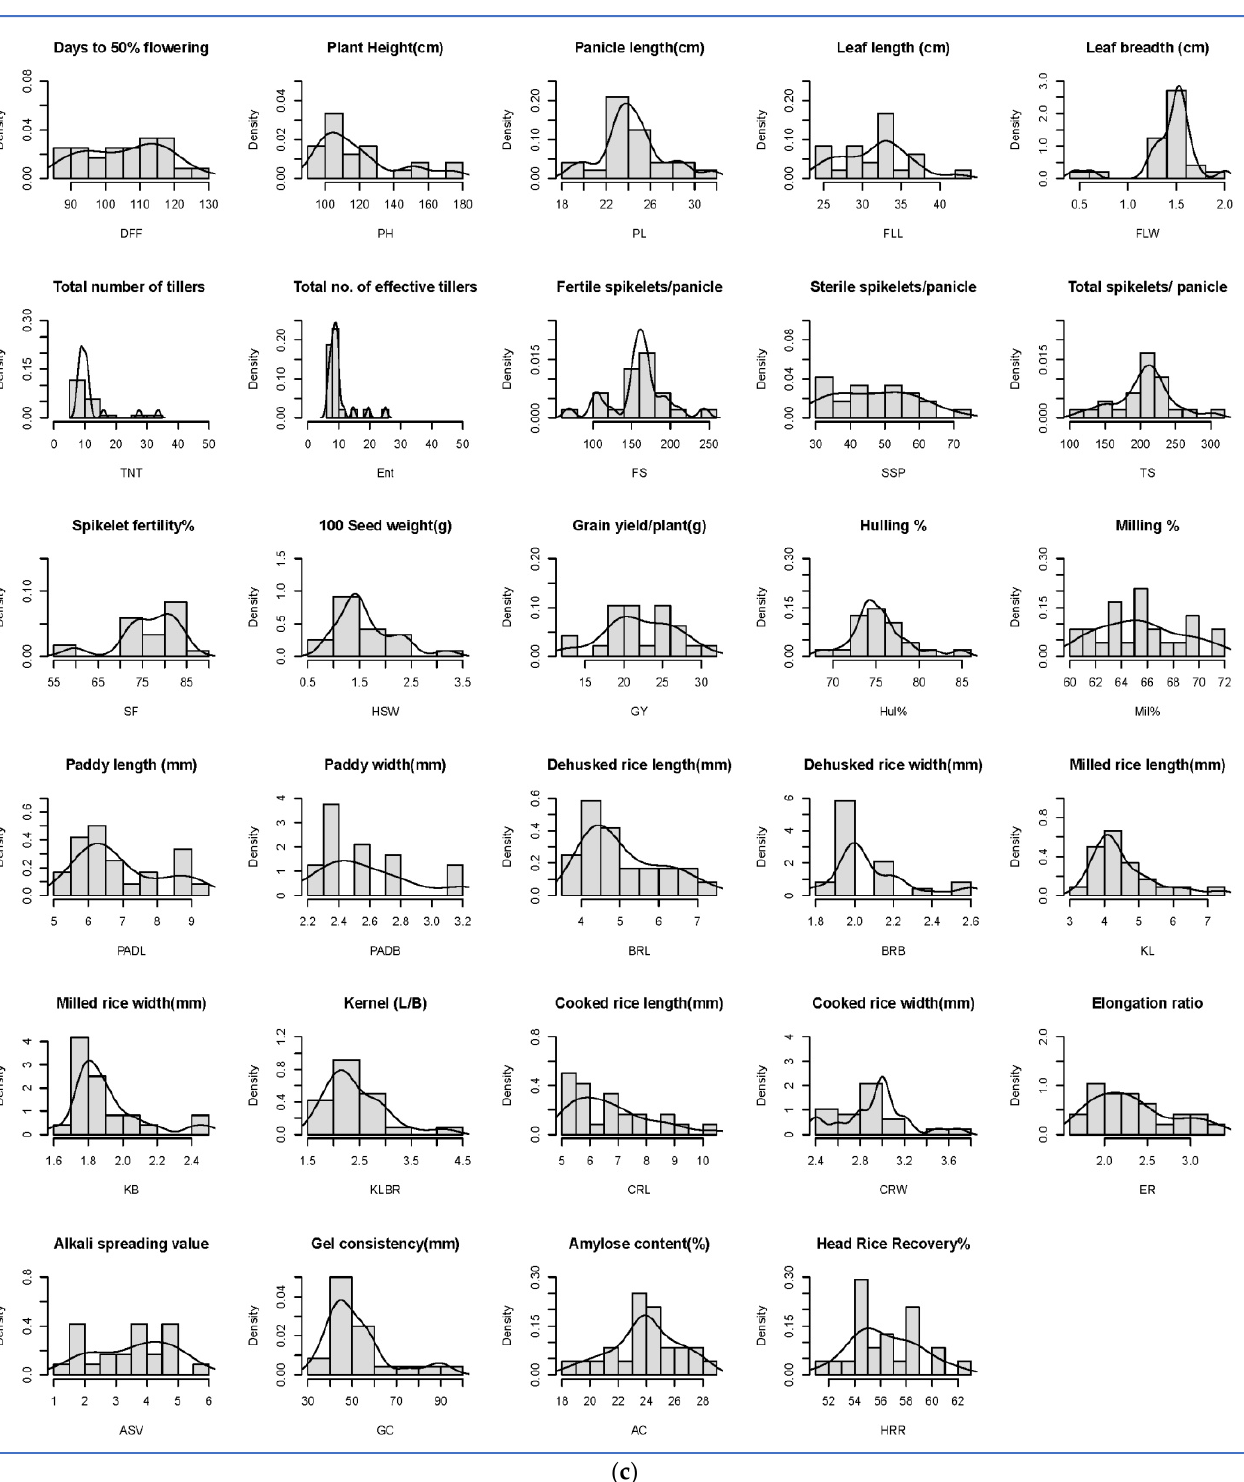
Figure 2. ( a ). Frequency distribution-based histogram for all the traits during the Kharif (wet) season—2019. ( b ). Frequency distribution-based histogram for all the traits during the Rabi (Dry) season—2019–20. ( c ). Frequency distribution-based histogram for all the traits during the Kharif (wet) season—2020. 2.4. Improvement in Days to 50% Flowering, Plant Height (cm) and Grain Yield per Plant (g) of the Rice Mutants over the Corresponding Parent